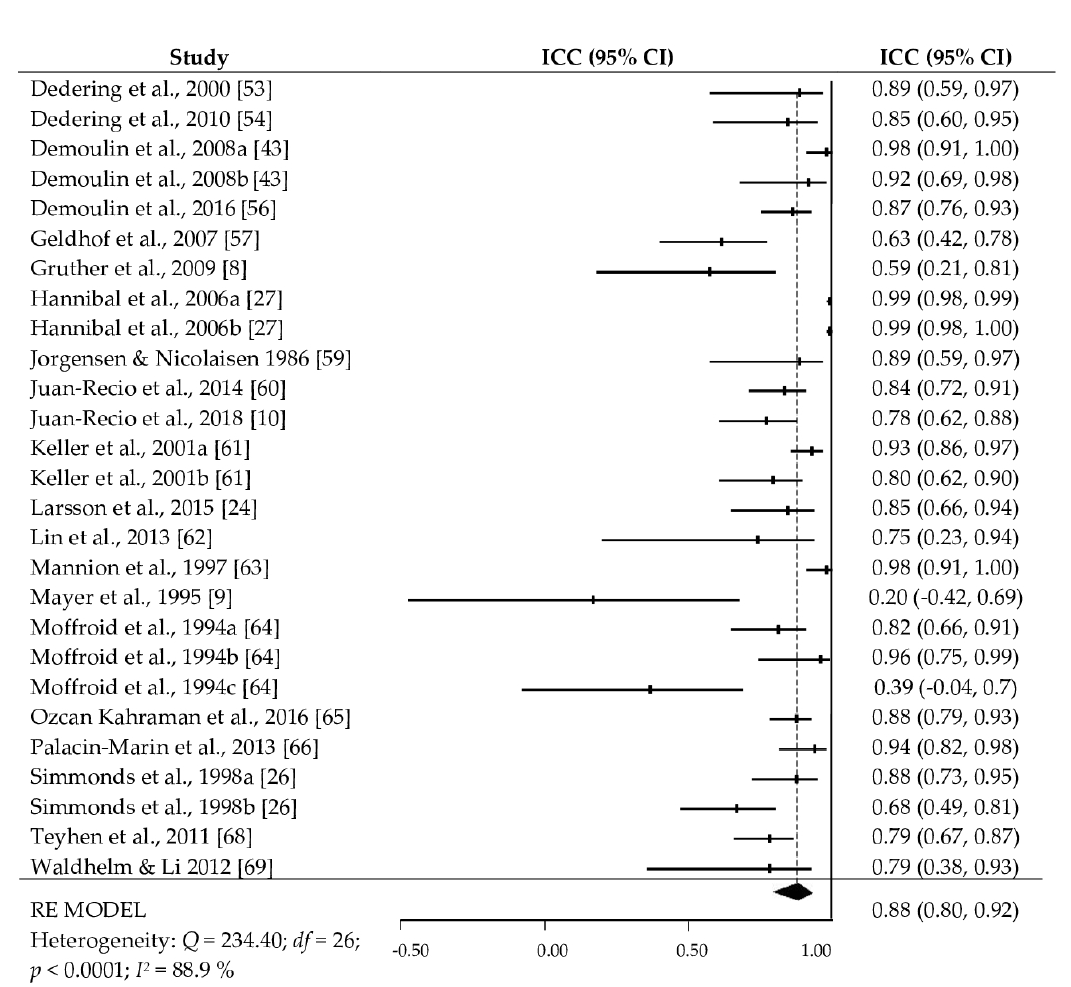
Figure 2. Forest plot of the intra-tester and inter-session reliability obtained in the studies that applied the Biering-Sorensen test. Table 3. Results of the mixed-e ff ects meta-regressions for the continuous moderator variables on the intraclass correlation coe ffi cient (ICC) estimates obtained from intra-tester and inter-session reliability of the Biering-Sorensen